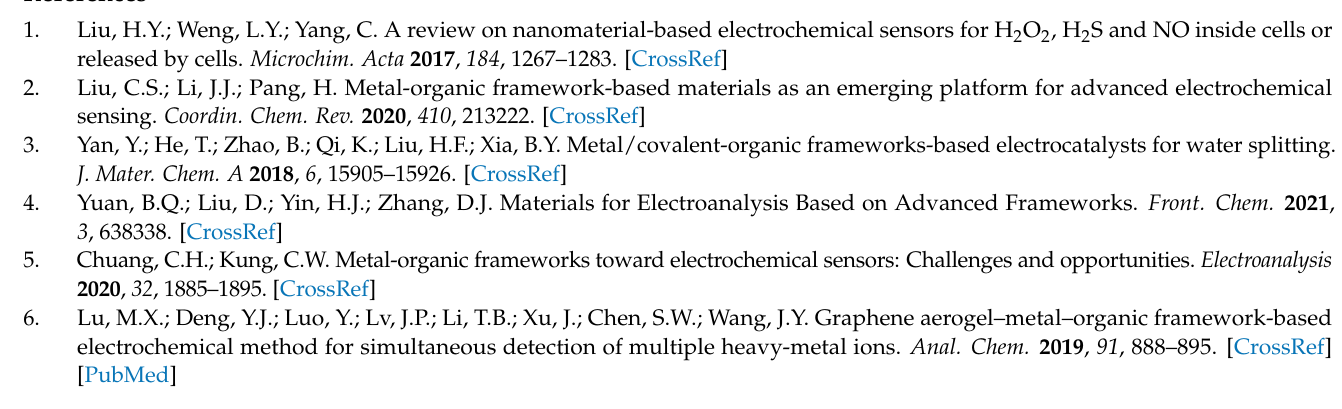
metric curve of Pd 2+ /COFs/GCE with 50 µ M hydrazine and 500 µ M of interferences such as KCl, NaCl, Na 2 SO 4 , NaBr, CaCl 2 , NaAc, glucose, (NH 4 ) 2 SO 4 , NaNO 3 , and NaNO 2 . (Electrolyte: 0.1 M NaOH); Figure S7: Amperometric curve of Pd 2+ /COFs/GCE for the detection of hydrazine spiked in water samples at − 0.1 V. (Electrolyte: 0.1 M NaOH); Figure S8: CVs of Bare GCE, COFs/GCE, and Pd 2+ /COFs/GCE in 0.1 M PBS at a scan rate of 50 mV s − 1 (pH = 7.0); Figure S9: CVs of 500 µ M of (a) ONP and (b) PNP on Pd 2+ /COFs/GCE with different scan rates (20–200 mV s − 1 ) in 0.1 M PBS (PH = 7.0). (Inset: the corresponding calibration plot.); Figure S10: DPV curves of 500 µ M of (a) ONP and (b) PNP on Pd 2+ /COFs/GCE in 0.1 M PBS (pH = 7.0) with different pH values (1–5: 6.5, 7.0, 7.5, 8.0, and 8.5). Plots of I pc vs. pH for (c) ONP and (d) PNP; Figure S11: Successive CVs of Bare GCE (a), COFs/GCE (b), and Pd 2+ /COFs/GCE (c) in the presence of 500 µ M nitrophenol ONP at a scan rate of 50 mV s − 1 in 0.1 M PBS (pH = 7); Figure S12: Successive CVs of Bare GCE (a), COFs/GCE (b), and Pd 2+ /COFs/GCE (c) in the presence of 500 µ M nitrophenol PNP at a scan rate of 50 mV s − 1 in 0.1 M PBS (pH = 7.0); Figure S13: Normalized peak current of bare GCE, COFs/GCE, and Pd 2+ /COFs/GCE in the presence of 500 µ M nitrophenol (a: ONP, b: PNP) at a scan rate of 50 mV s − 1 in 0.1 M PBS (pH = 7.0) for ten cycles; Figure S14: SEM (a) and TEM (b) images of PCs; Figure S15: CVs of 5 mM of GSH on (a) PCs/CPE in 0.1 M PBS with different pH values (1–5: 3.0, 3.5, 4.0, 4.5 and 5.0). Plots of I pc vs. pH for (b) GSH; Figure S16: Amperometric responses of PCs/CPE to additions of various concentrations of GSH in 0.1 M PBS (pH = 4.0) at 0.25 V. (Inset: the corre- sponding calibration plot.); Figure S17: Amperometric responses of PCs/CPE to successive additions of various concentrations of GSH spiked in serum in 0.1 M PBS (pH = 4.0) at 0.25 V; Figure S18: Amperometric responses of PCs/CPE for the detection of GSH spiked in human serum in 0.1 M PBS (pH = 4.0) at 0.25 V; Table S1: Comparison of the Pd 2+ /COFs/GCE for different parameters with pre- viously reported hydrazine electrodes; Table S2: Determination of hydrazine spiked in water samples; Table S3: Comparison of different modified GCE for detection of ONP and PNP; Table S4; Comparison of different modified electrodes for electrochemical sensing of GSH; Table S5; Determination of GSH spiked in human serum by successive additions;Table S6; Determination of GSH spiked in human serum by a non-successive addition method. References [36–68] were cited in the Supplementary